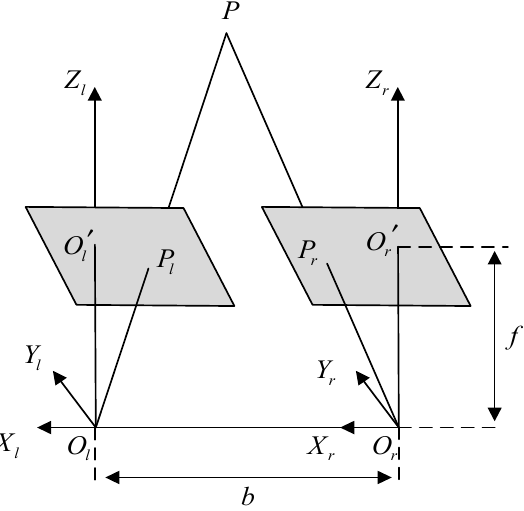
Figure 5. Geometric relationship of parallel binocular camera imaging. O l and O r in Figure 5 represent the optical centers of left and right cameras respectively. The length of O l and O r lines is b , and the focal length of both cameras is f . The coordinates of a point P in three-dimensional space on two camera imaging planes are represented by P l = ( x l , y l ) and P r = ( x r , y r ) , respectively, and the coordinate of P in the left camera coordinate system is ( X , Y , Z ) . Furthermore, since the imaging point has no parallax in the Y l -axial direction, y = y l = y r can be obtained by the similar triangle principle (4). Let the horizontal parallax d = x l − x r of point P in the two images; combined with (4), we can obtain the three-dimensional coordinates of corresponding points in the left and right images in space, as shown in (5). Therefore, for the matching feature points in the left and right images of the same frame in the parallel binocular endoscope, the three-dimensional coordinates in the left camera coordinate system can be obtained by combining (5) and binocular geometric constraints.